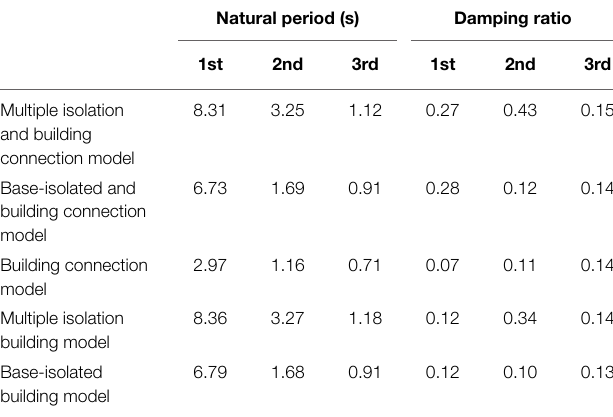
TABLE 1 | Natural period and damping ratio (first, second, and third modes)